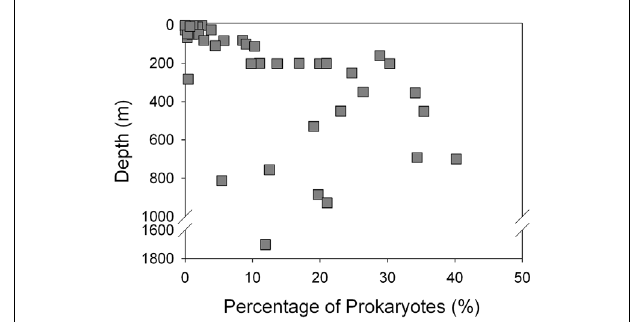
FIGURE 3 |Abundance ofThaumarchaeota as a percentage of total bacterioplankton plotted against sample depth.